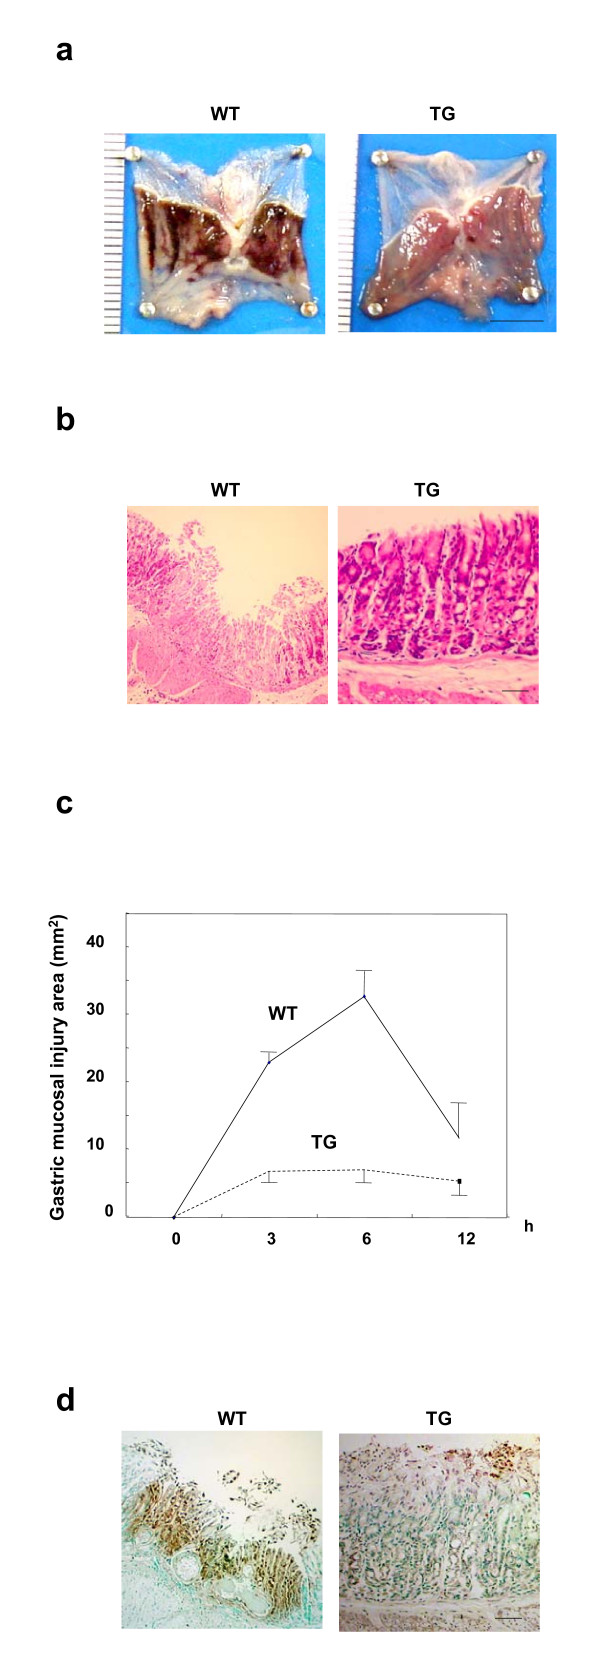
Ethanol-induced gastric injury in the gastric mucosae. (a) Macroscopic view of the gastric mucosa. Scale: 5 mm. Both mucosae are 6 h after ethanol administration. Note that the WT mucosa displays extensive hemorrhagic lesions, in contrast, the TG mucosa looks undamaged after ethanol administration. (b) Hematoxylin and eosin staining of ethanol-injured WT mucosa (left) and TG mucosa (right). Note the deep ulcer formation in the WT mucosa. Scale: 100 μm. (c) Time course of ethanol-induced gastric injury. Injured area is plotted against time up to 12 h after the ethanol administration. Each point represents an average of five mice. p < 0.05 (d) TUNEL staining of WT mucosa (left) and TG mucosa (right). Both sections are consecutive to those in 2B, respectively. Apoptotic cells are visible with dark-brown nuclei. Numerous apoptotic cells are noted in the WT mucosa. All photos were 6 h after the ethanol administration. Scale: 100 μm.